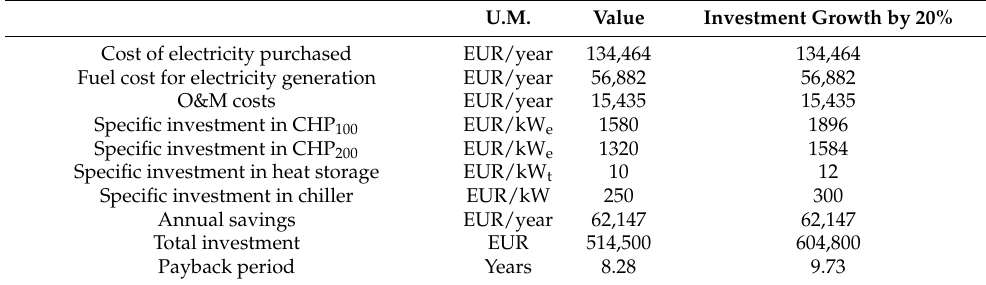
Table 8. Trigeneration (1 × 100 kW e , 1 × 200 kW e , 1 × 130 kW t , 1 × 256 kW t ) and heat storage: summary results.